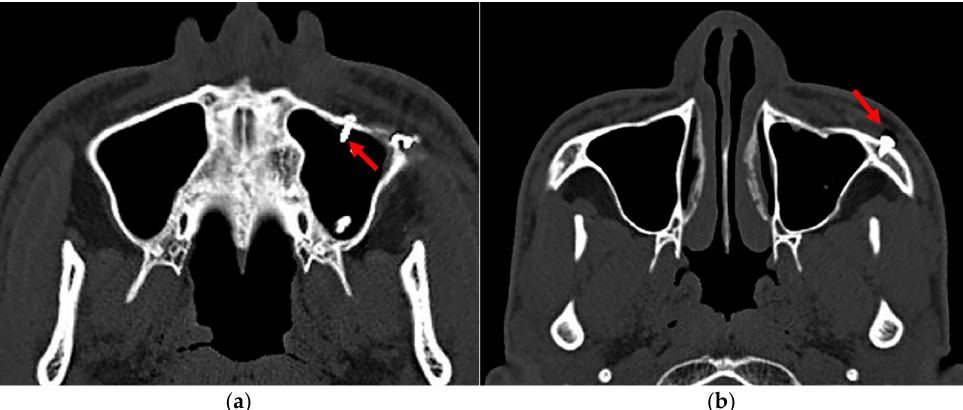
Figure 2. Implant penetration into the maxillary sinus. ( a ) The arrow indicates the implants (screws) penetrated the maxillary sinus. ( b ) The arrow indicates the implants (screws) within the maxillary sinus wall.